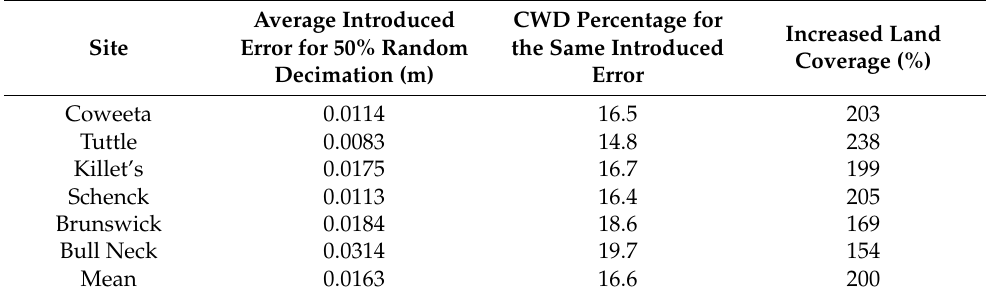
Table 6. Fixed introduced error comparison between Random and Curvature Weighted Decimation for root mean square